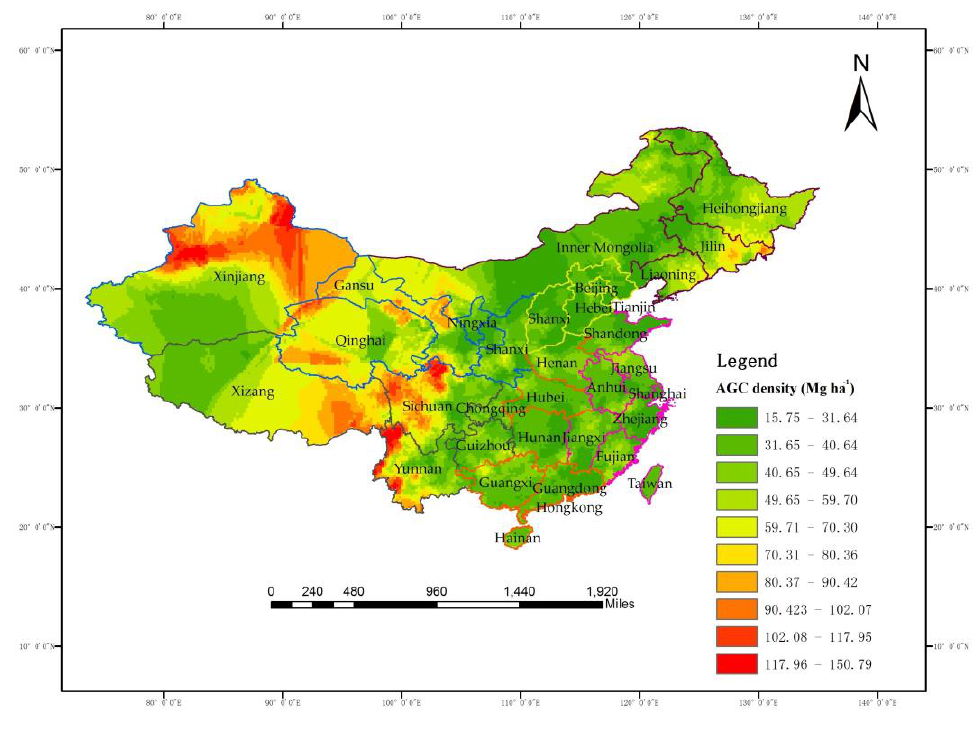
Figure 4. Aboveground carbon (AGC) density distribution in China. Table 10. Aboveground biomass (AGB) and aboveground carbon (AGC) in different regions of China.